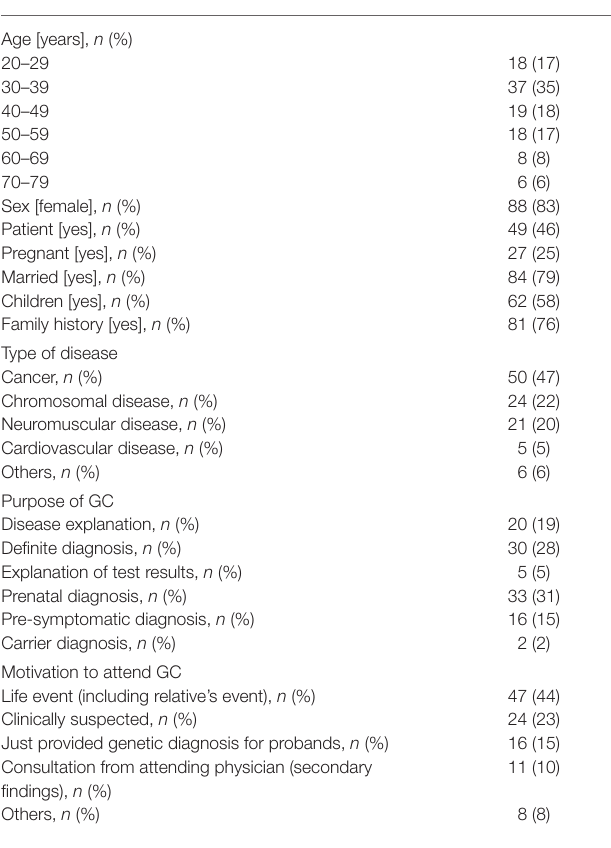
TABLE 3 | Characteristics of the GC